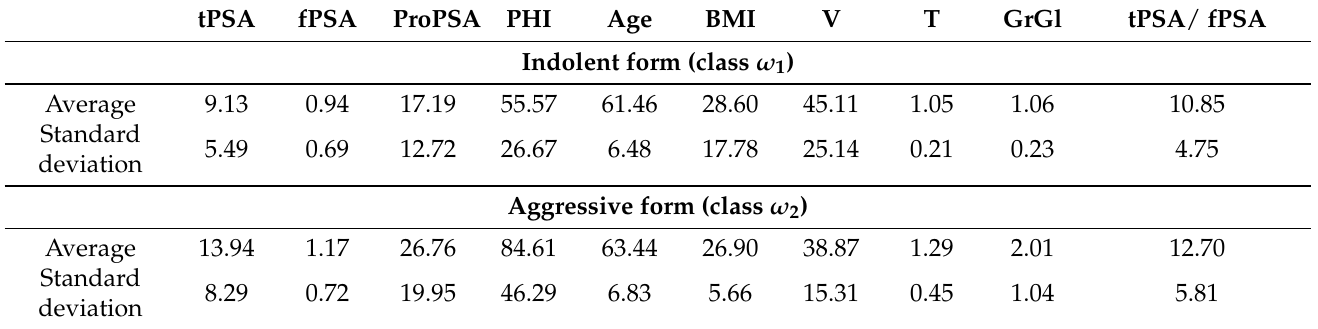
Table 3. Statistical indicators of a sample of patients with indolent (class ω 1 ) and aggressive (class ω 2 ) prostate